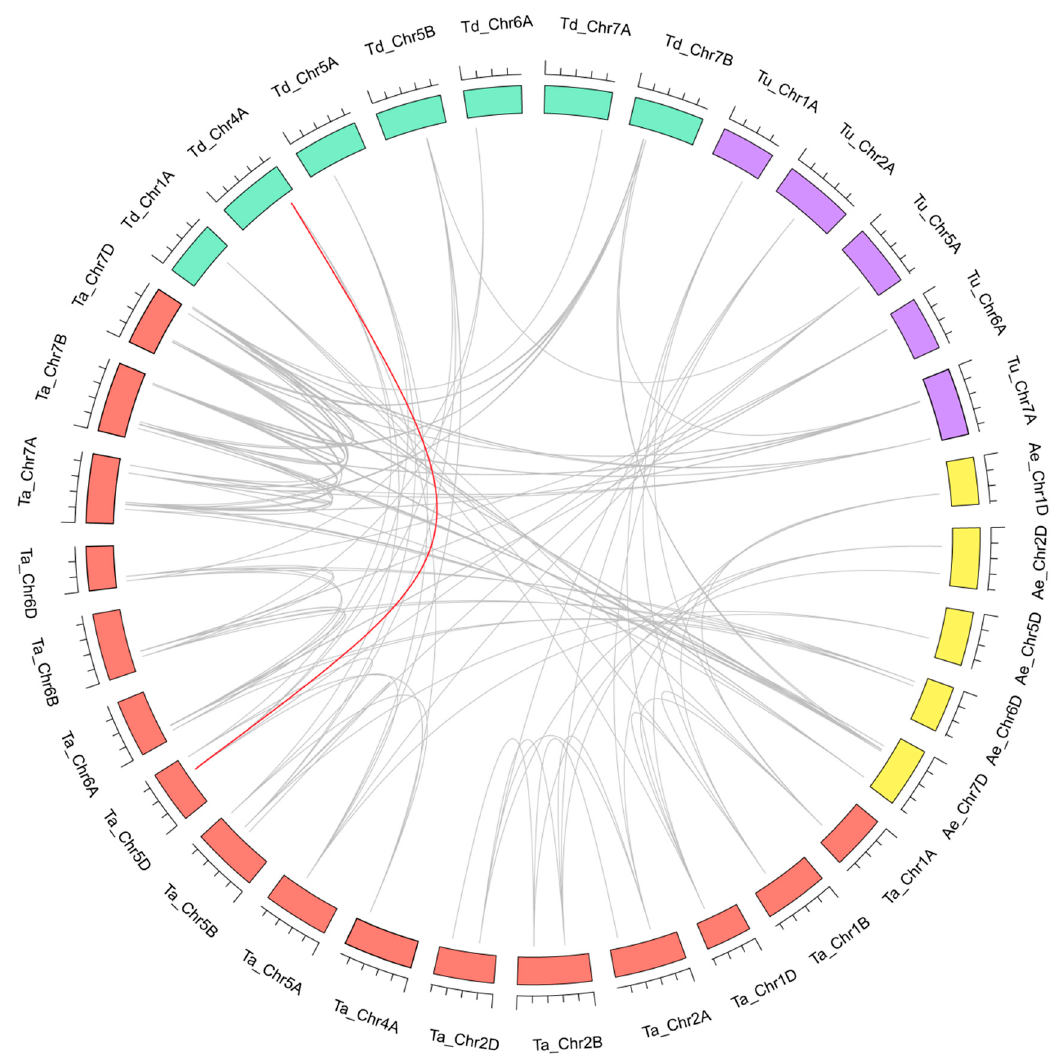
Figure 5. Orthologous relationships between wheat and its genome ancestors. Numbers along each chromosome box indicate sequence lengths in megabases. Lines between two chromosomes represent the syntonic relationships. The Triticum aestivum , Triticum urartu , Triticum dicoccoides and Aegilops tauschii chromosomes are shown in different color boxes and labeled Ta (red), Tu (purple), Td (green), and Ae (yellow). The red line in the figure is connected to gene pairs TaSBP6-DLa vs. TdSBP11-ALa.